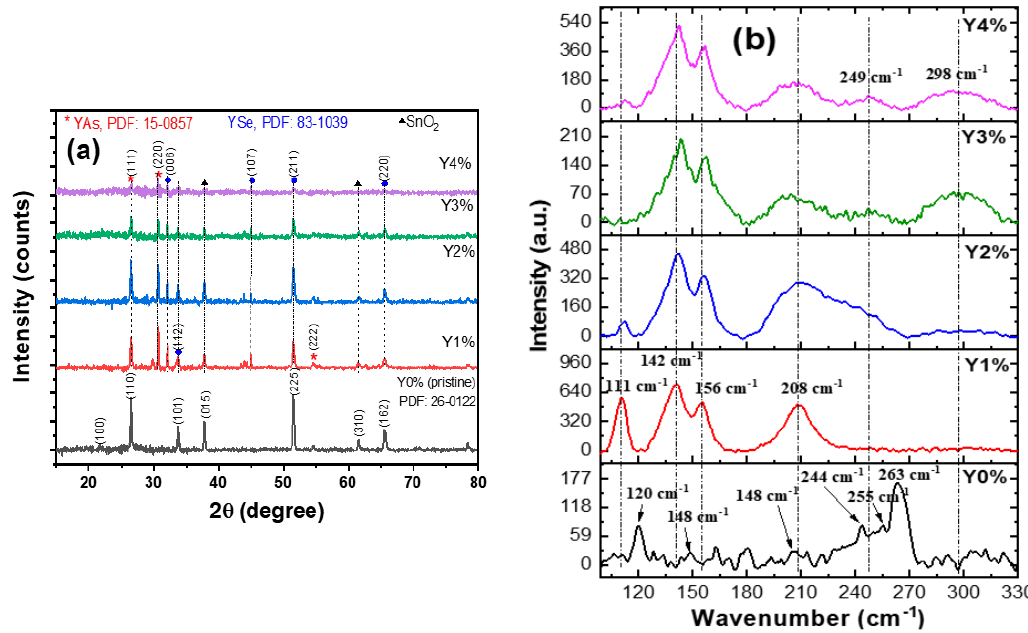
Figure 1. ( a ) XRD pattern ( b ) Raman spectra of pristine and composite films.